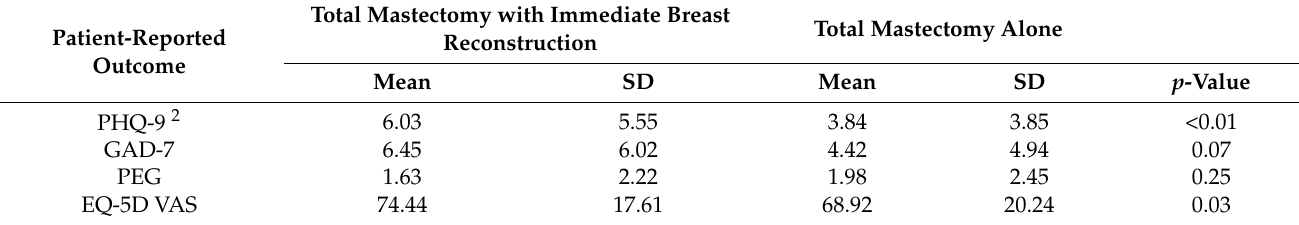
Table 6. Patient-reported outcome statistics presented for the total mastectomy subgroup stratified by receipt of immediate breast